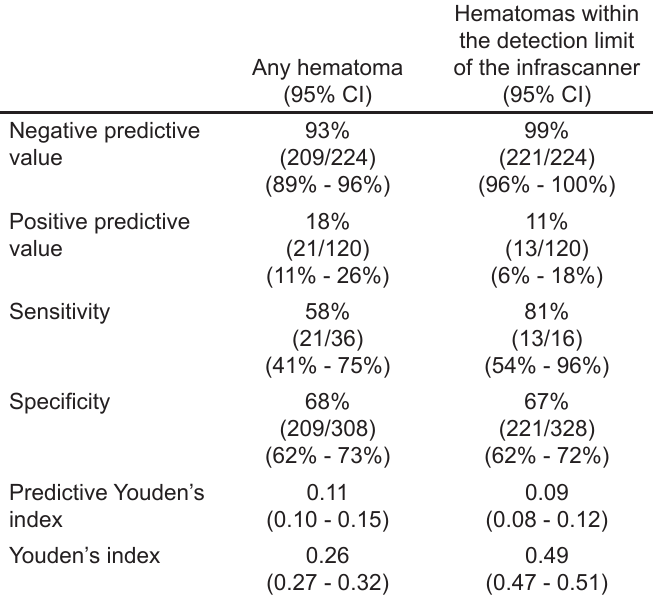
Table 2. Infrascanner diagnostic performance.